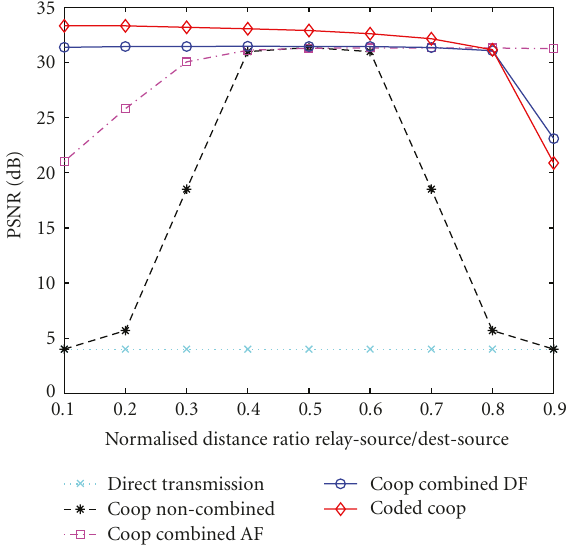
Figure 4: PSNR versus Relay Location (Video Foreman).